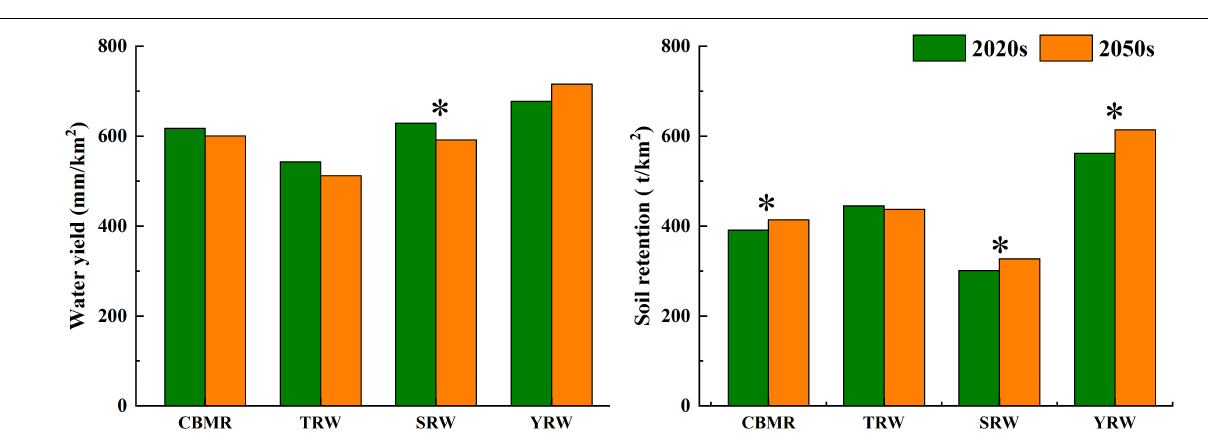
FIGURE 4 | Water yield and soil retention in 2020 and 2050s for the Changbai mountains region (CBMR) and three watersheds (the sign “*” indicated significant differences at the 0.05